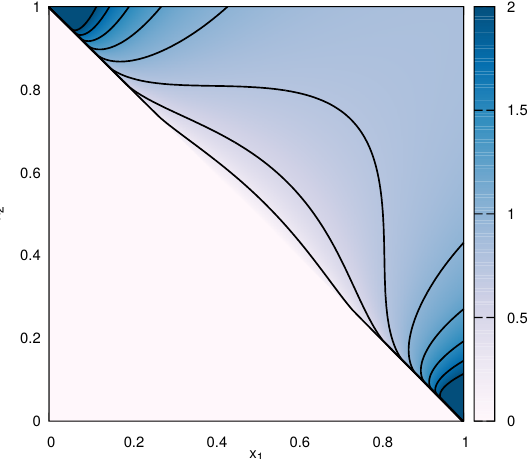
Figure 1 . A contour plot that displays our numerical results for the integral I wa ( (cid:18) 12 ) de(cid:12)ned in eq.